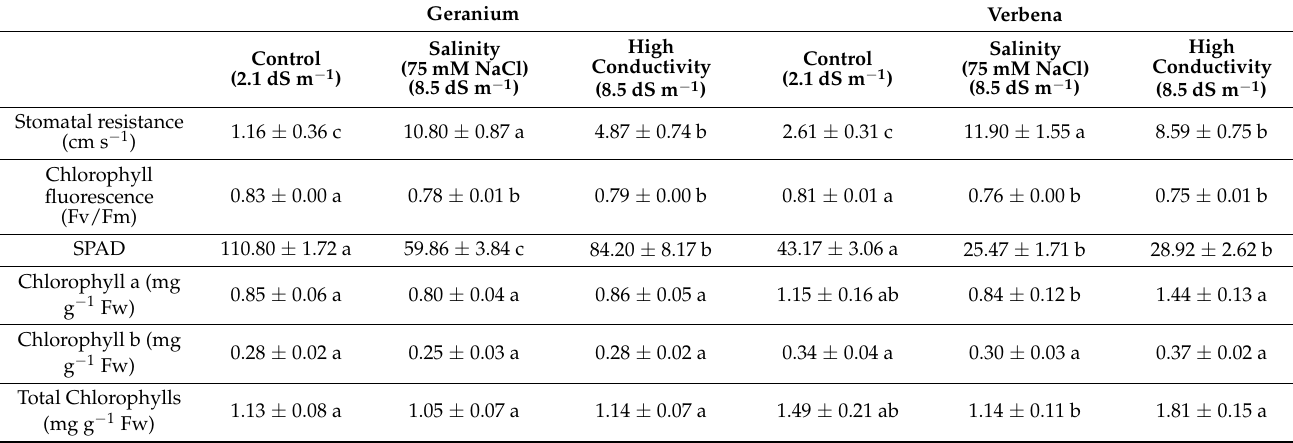
Table 2. Influence of salinity (75 mM NaCl; 8.5 dS m − 1 ) and high electrical conductivity (8.5 dS m − 1 ) on leaf stomatal resistance (cm s − 1 ), leaf fluorescence (Fv/Fm), SPAD index, chlorophyll (Chl a, Chl b, Total Chl) content (mg g − 1 fresh weight-Fw) in geranium and verbena plants grown hydroponically in perlite substrate (mean ± SE, n = 6).